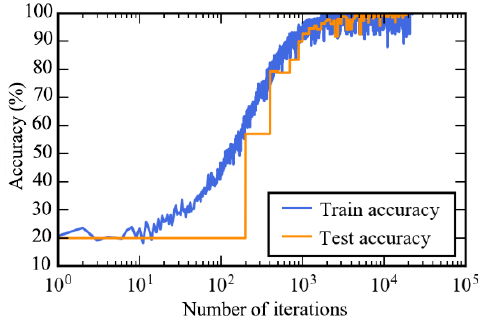
Fig. 12 Train and test accuracy with 2000 samples in Case